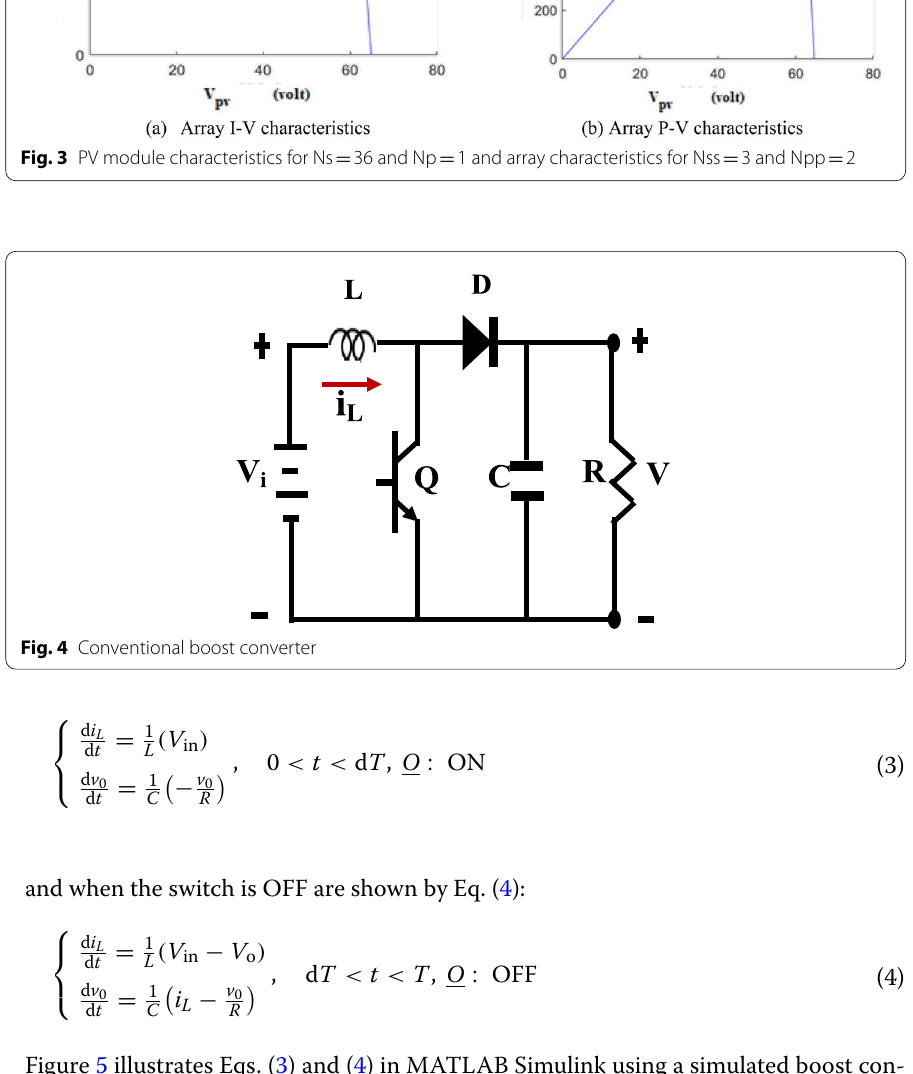
Fig. 3 PV module characteristics for Ns